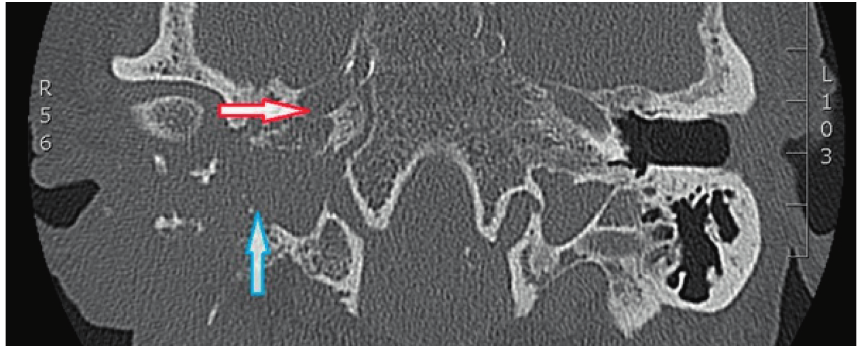
Figure 4: Axial view of temporal CT 5 months after the initial surgery showing complete opacification and massive bone erosion of the middle ear and mastoid on the right side indicating an extended soft tissue mass adjacent to the carotid canal (red arrow) and jugular bulb (blue arrow) and partially obliterating the temporal mandibular joint.